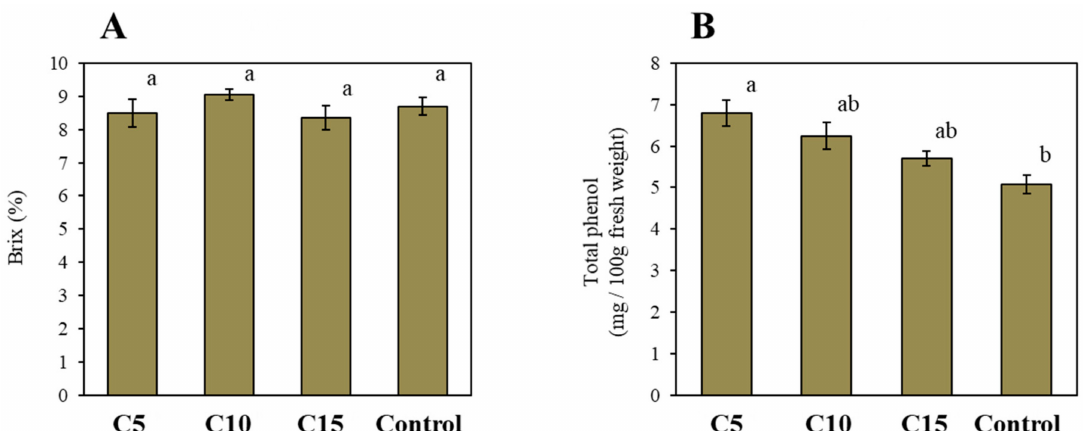
Figure 7. E ff ect of partial taproot excision on the concentration of sugar ( A ) and total phenols ( B ) of carrot taproots 28 days after partial taproot excision. Vertical bars represent the means ± SE ( n = 4). Di ff erent letters indicate significant di ff erences as determined by Tukey’s multiple comparison test ( p <